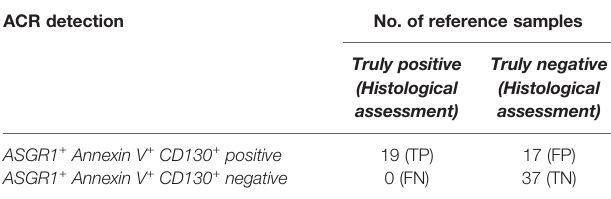
TABLE 3 | Diagnosis sensitivity and speci fi city of ASGR1 + Annexin V + CD130 + EP (%) for ACR in liver transplant. ACR detection